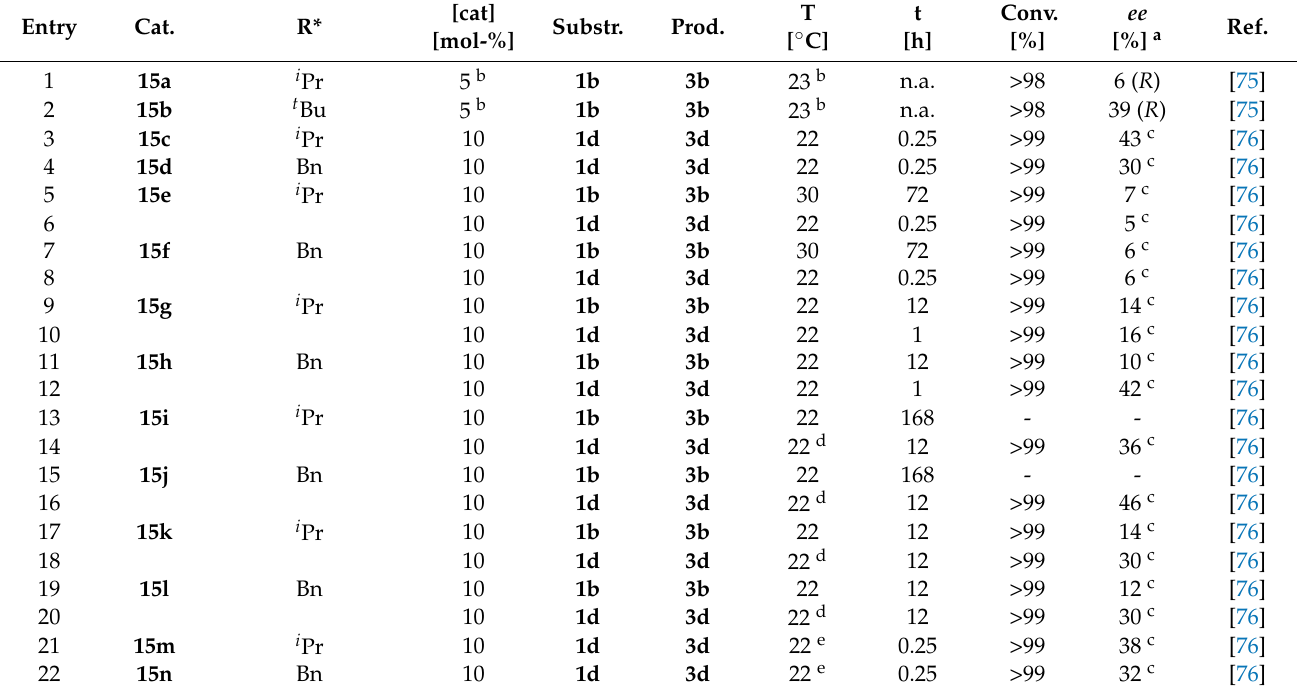
Table 4. Catalytic asymmetric hydroamination reactions of 1a – e and 2c , d using chiral rare earth metal complexes 15a – n , 16a – d , 17a , 18 and 19a , b